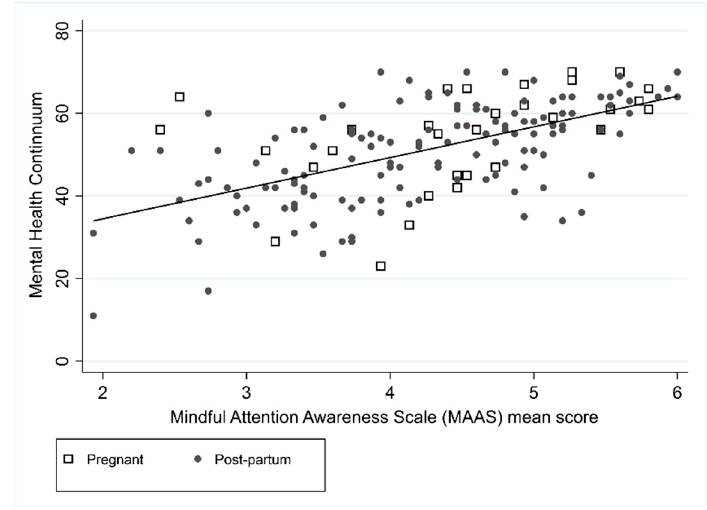
Figure 2. Association between MHC and MAAS. Perceived stress was negatively correlated with the SCS score ( r = − 0.63) and MAAS scores ( r = − 0.61), suggesting that higher levels of perceived stress were associated with lower levels of self-compassion and mindfulness (Figures 3 and 4). Pregnancy was asso- ciated with the PSS in the unadjusted model, with pregnant women on average having lower levels of stress compared to postpartum women, however after adjusting for SCS and MAAS this relationship did not remain significant. In the unadjusted and adjusted PSS models, SCS and MAAS were statistically significant. In the adjusted model, an increase in SCS of 1 resulted in a decrease in PSS of 3.6 (95% CI: − 4.8 to − 2.3) and an increase in mindfulness of 1 resulted in a decrease in PSS of 2.6 (95% CI: − 3.6 to − 1.6). Forty-nine percent of the variance was explained by the combination of SCS score and MAAS score (R 2 = 0.49).